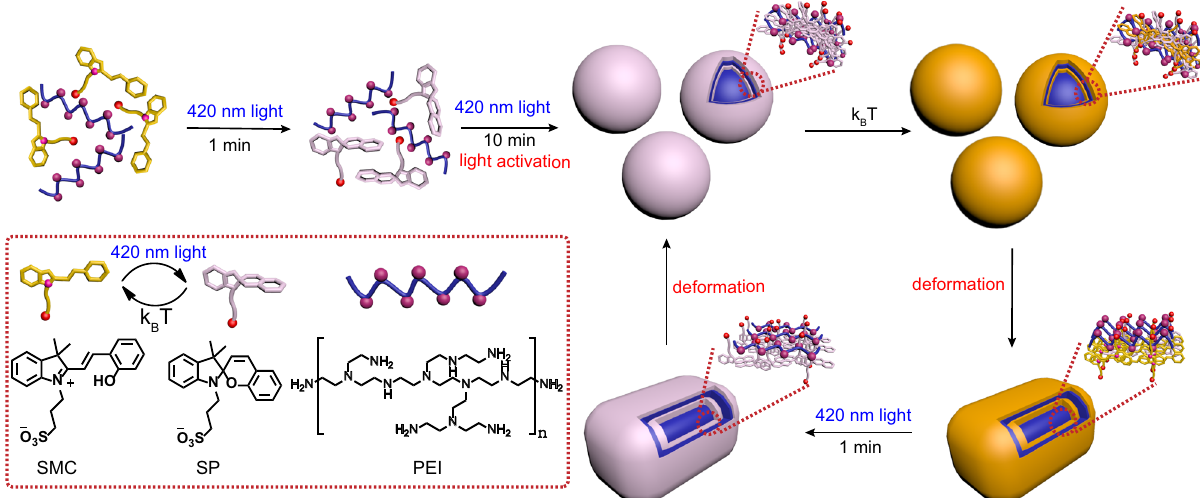
Fig. 1 Schematic illustration of the light-activated supramolecular DSAs. Light-activation process for dissipative self-assembly (initial two steps), and reversibly photodeformable dissipative self-assembly under light irradiation/thermal relaxation cycles (following steps in the loop). The schematic and chemical structures of SMC, SP, and PEI are shown in the dashed